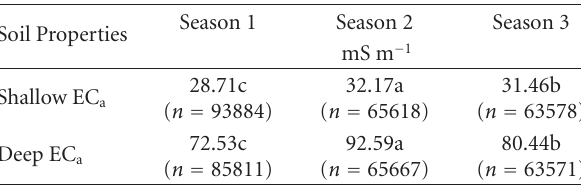
Table 3: Mean of the EC a for Seasons 1, 2, and